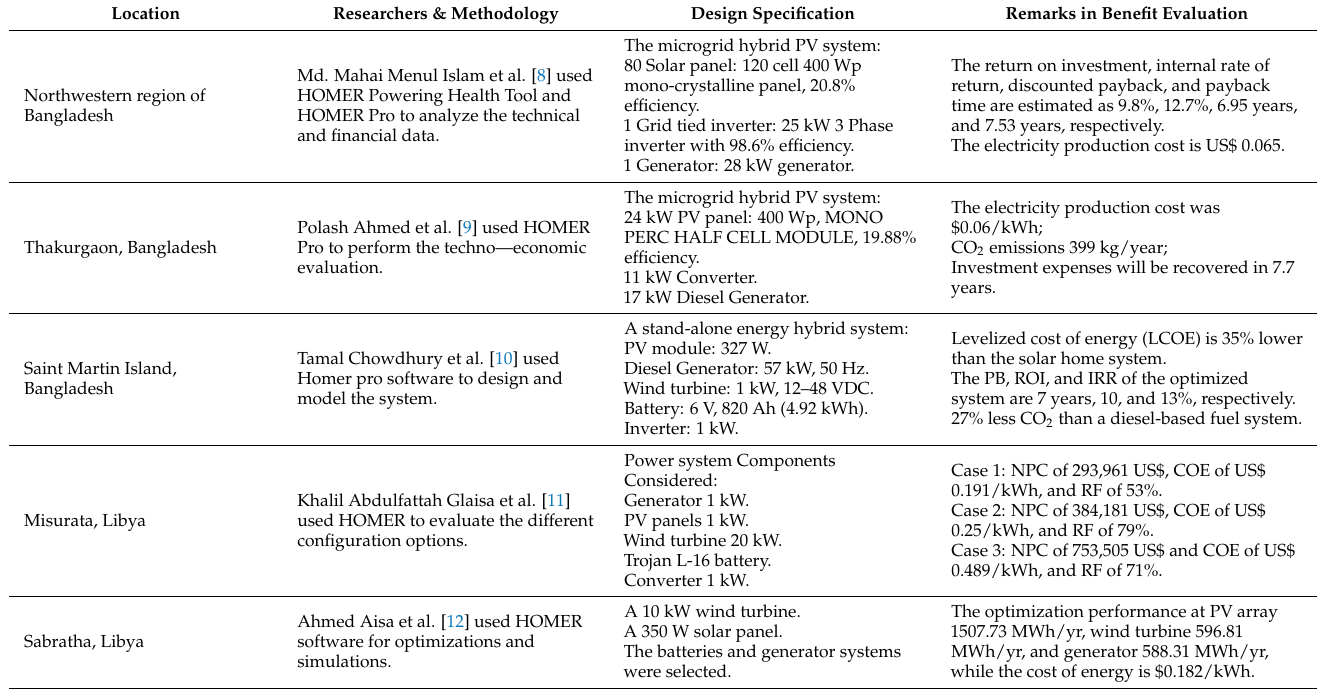
Table 1. The recent progress and similar